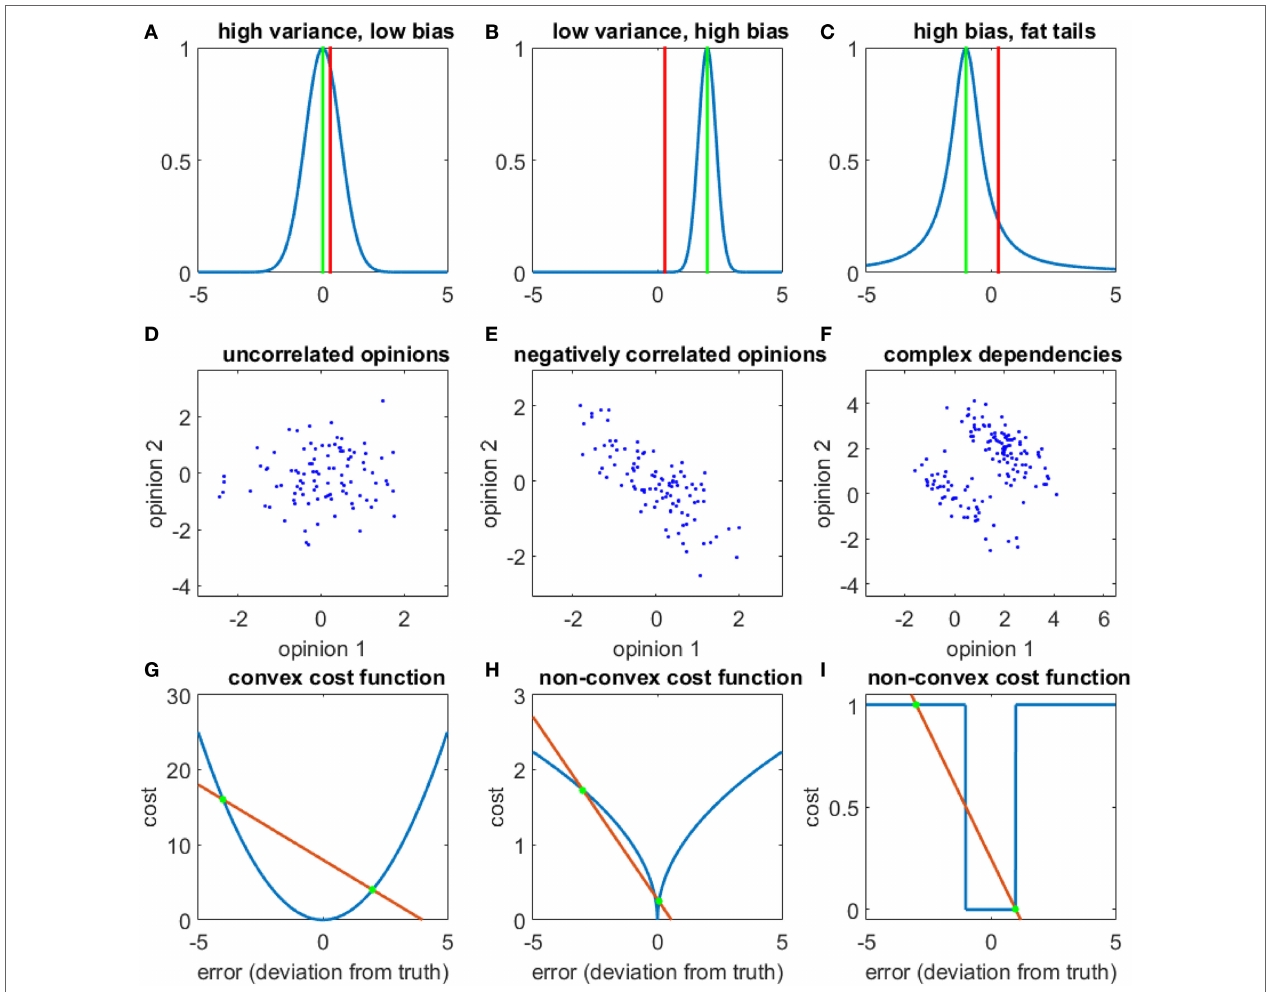
FIGURE 1 | The three factors that influence aggregation rules. (A–C) : the relationship between individual opinions and the truth. Blue curves show group opinion distributions, red lines mark the location of the truth, and green lines mark the average group opinion. (A) A low bias but high variance distribution. (B) A high bias, low variance distribution. (C) A biased distribution with fat tails marked by the slower decay of the probability distribution away from the mean. (D–F) The relationship between the opinions of two individuals. (D) Uncorrelated opinions. (E) Negatively correlated opinions. (F) A complex dependence between two individual’s opinions. (G–I) Various cost functions. (G) A convex cost function (see Section 5 and Appendix A1.1–1.2 for more extended discussions). (H,I) Two non-convex cost functions. In order to illustrate the property of convexity, we have also intersected each cost function with a red line. See section 5 for a further